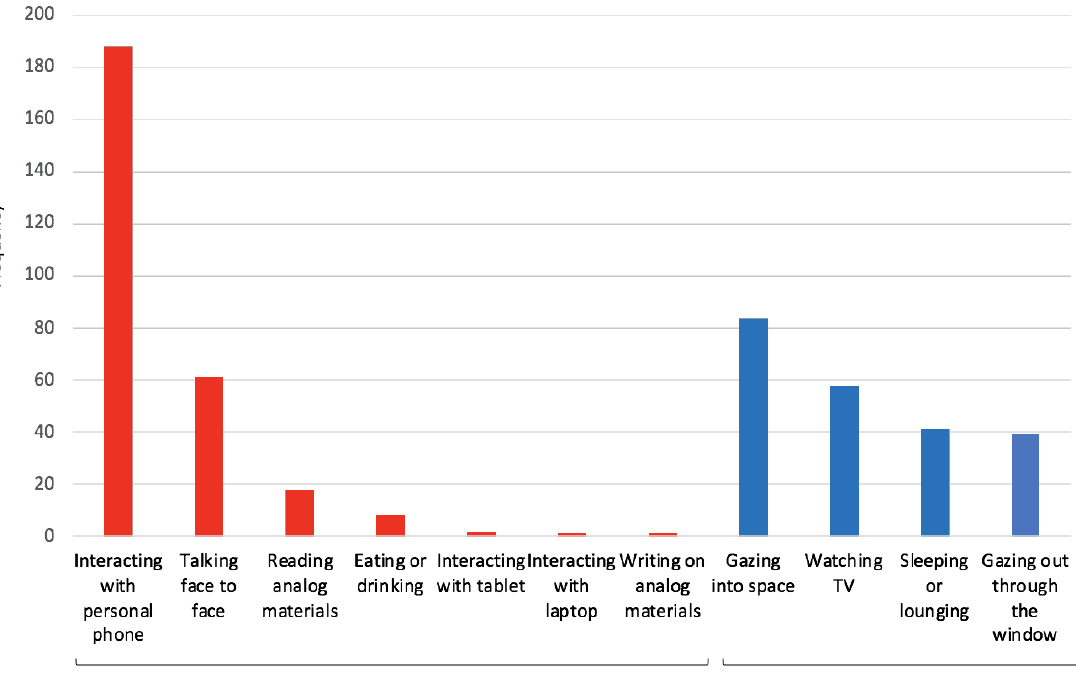
Figure 4. Frequency of